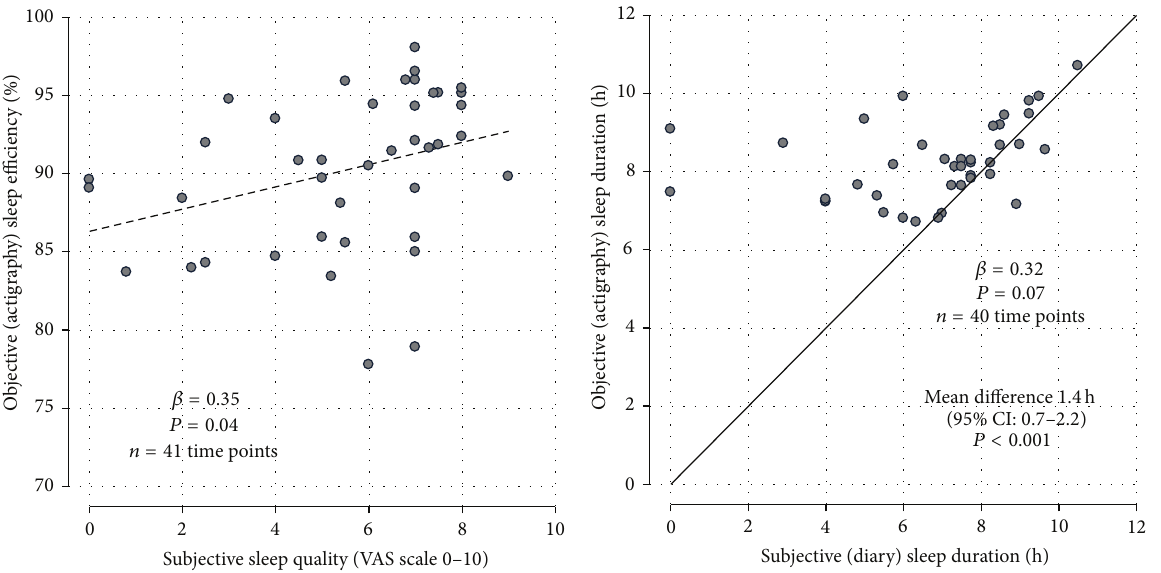
Figure 2: Scatterplots showing the relationship between subjective and objective sleep parameters.